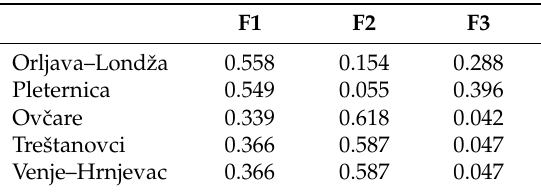
Table 10. Squared cosines of the observations for Scenario 1.